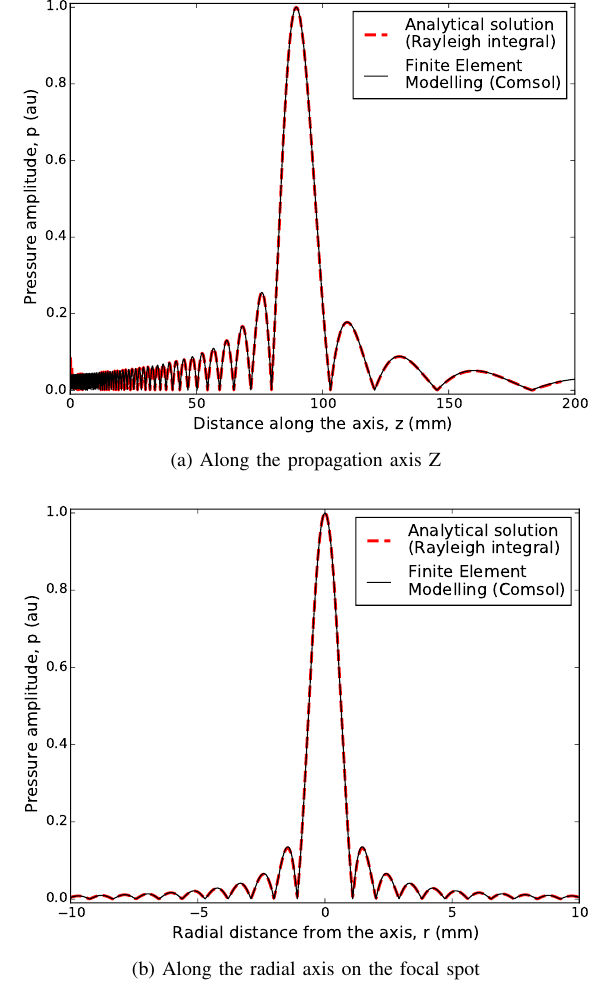
Fig. 7. Evaluation of the pressure field’s amplitude for the Rayleigh’s configuration (2D field and evaluation axes on figure